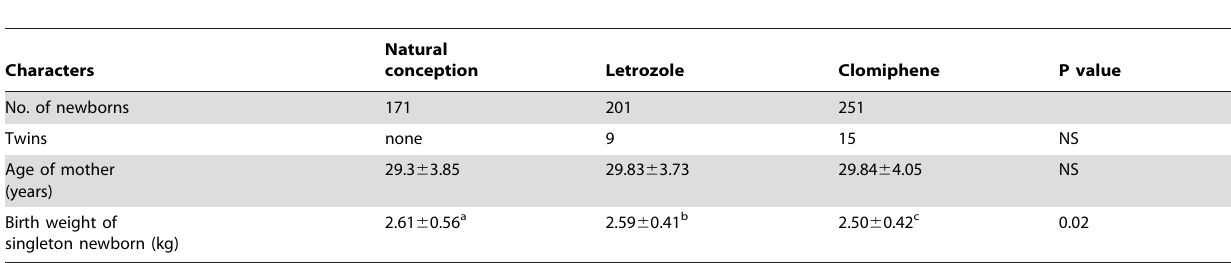
Table 2. Birth weight of the newborns, incidence of multiple births and age of the mother who conceived following natural conception/letrozole/CC.